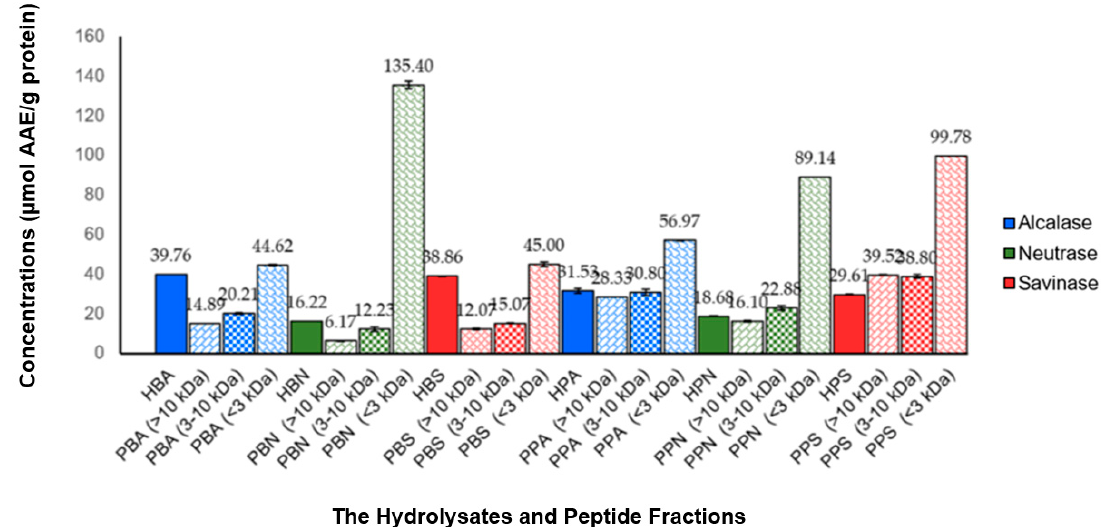
Figure 2. Antioxidant activities of hydrolysates and peptide fractions tested using the scavenging technique against DPPH radicals. Antioxidant activities were expressed in µmol AAE/g protein. All values were given as mean ± SD, n = 2. The values of antioxidant activities for each hydrolysate and its peptide fractions showed a significant difference with the one-way ANOVA test ( p < 0.05).